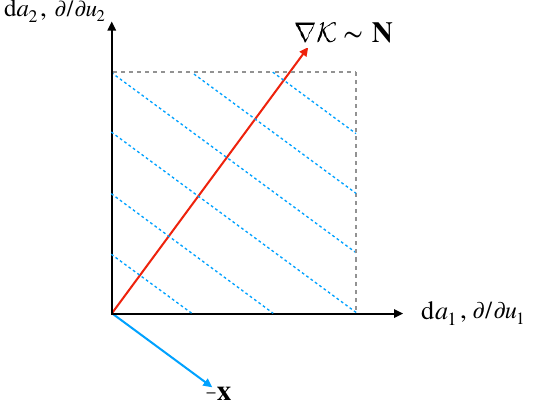
Figure 3 . Misaligned trajectory, labelled by x , in two-moduli space. In this case, the vector rK is not aligned with any of the coordinate